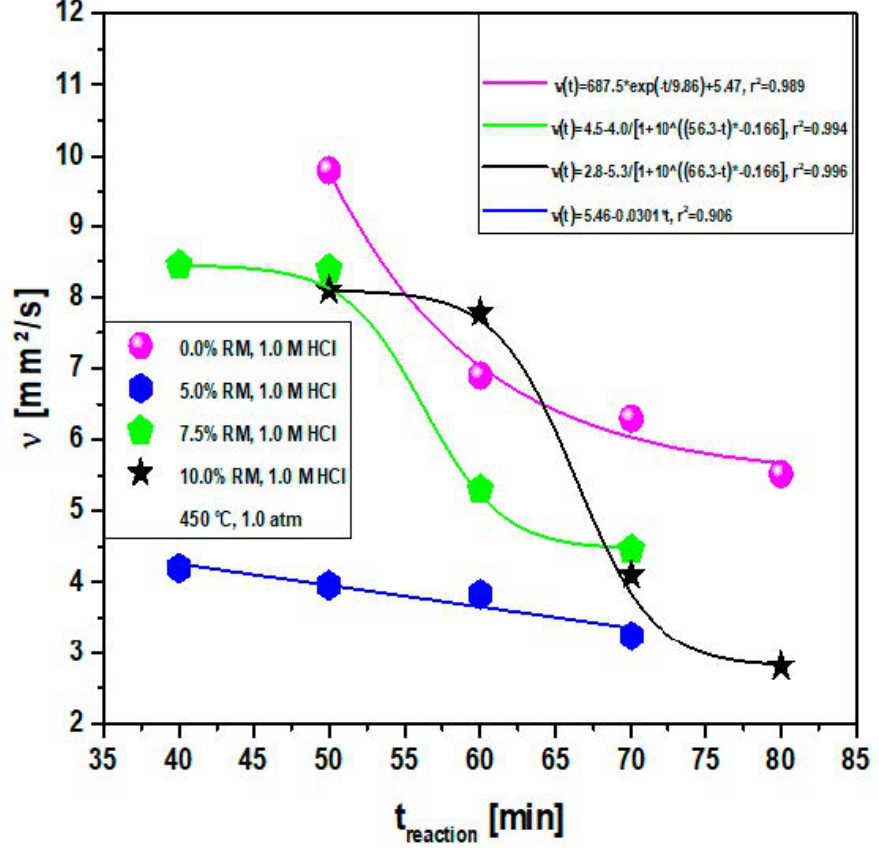
Figure 14. Effect of reaction time on the kinematic viscosity of bio-oil obtained through the upgrading process.